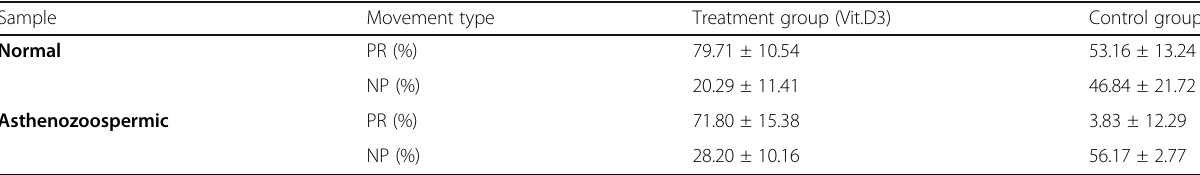
Table 2 Mean of sperm motility from the samples after incubation with vitamin D3